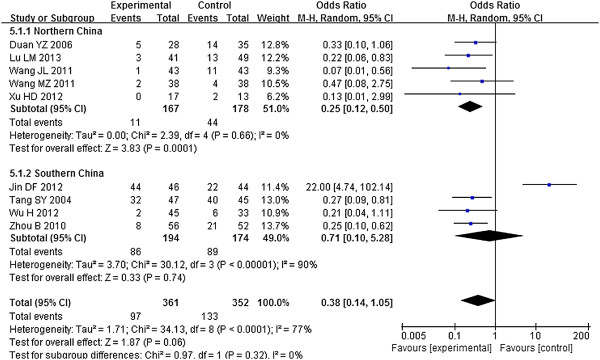
The forest plot of postoperative complication rate.